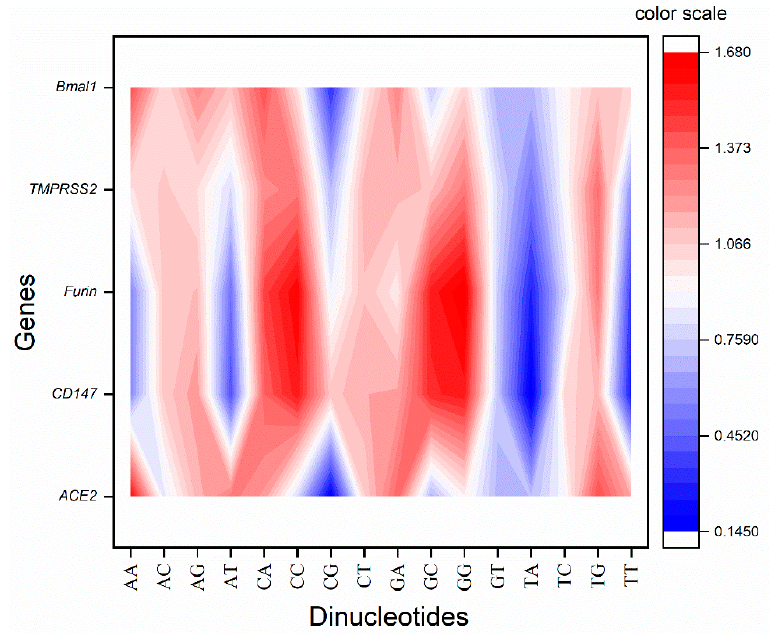
Figure 2. Contour plot for the dinucleotide odds ratio. The blue color shows underrepresentation, while the red shows an overrepresentation of dinucleotides. while the red shows an overrepresentation of dinucleotides.